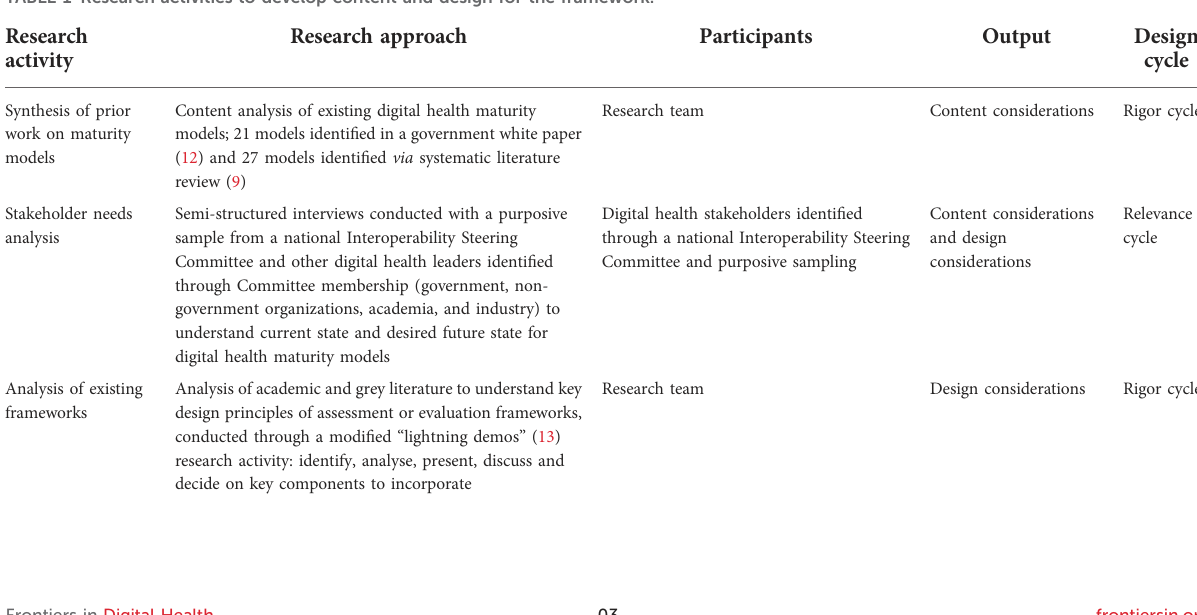
TABLE 1 Research activities to develop content and design for the framework. Research